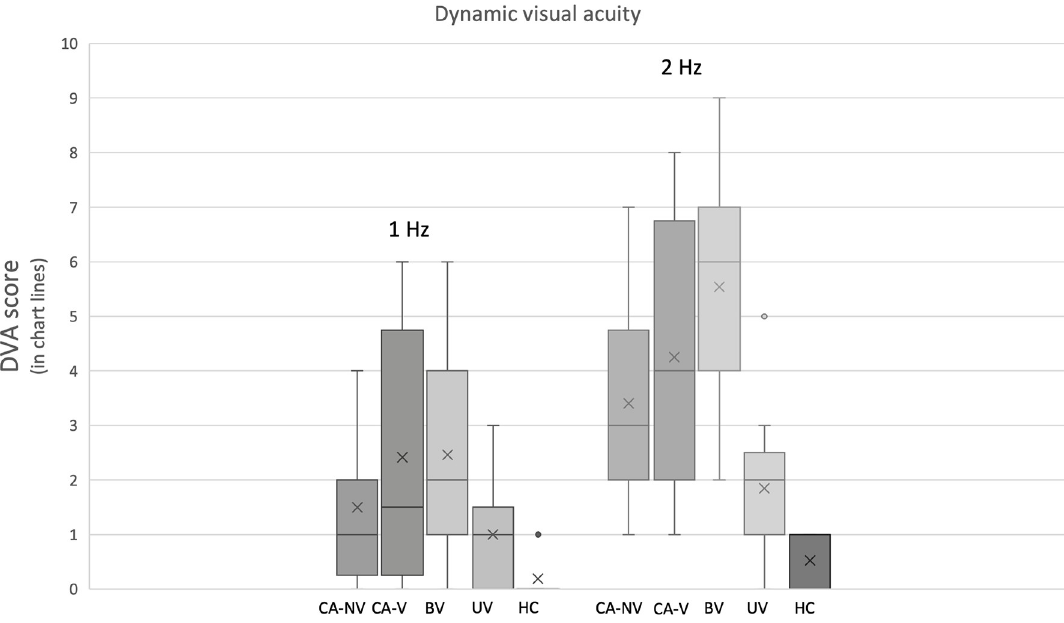
Fig 1. Distribution of DVA scores among the groups (boxplot graph). CA-NV–cerebellar ataxia without vestibulopathy, CA-V– cerebellar ataxia with vestibulopathy, BV–bilateral vestibulopathy, UV—unilateral vestibulopathy, HC–healthy controls.